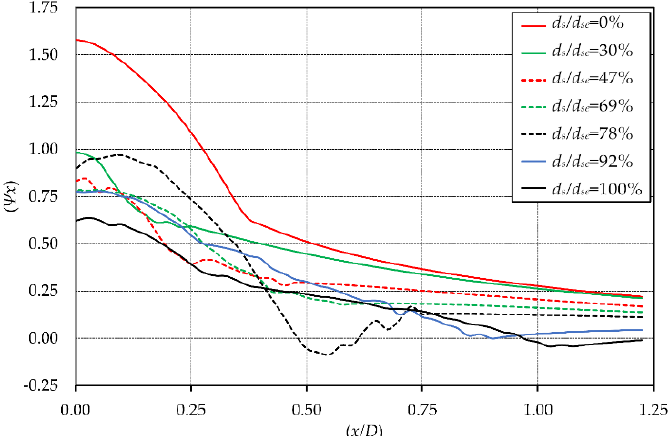
Figure 17. Variation of area-averaged dimensionless circulation ( Ψ x ) during scouring stages.